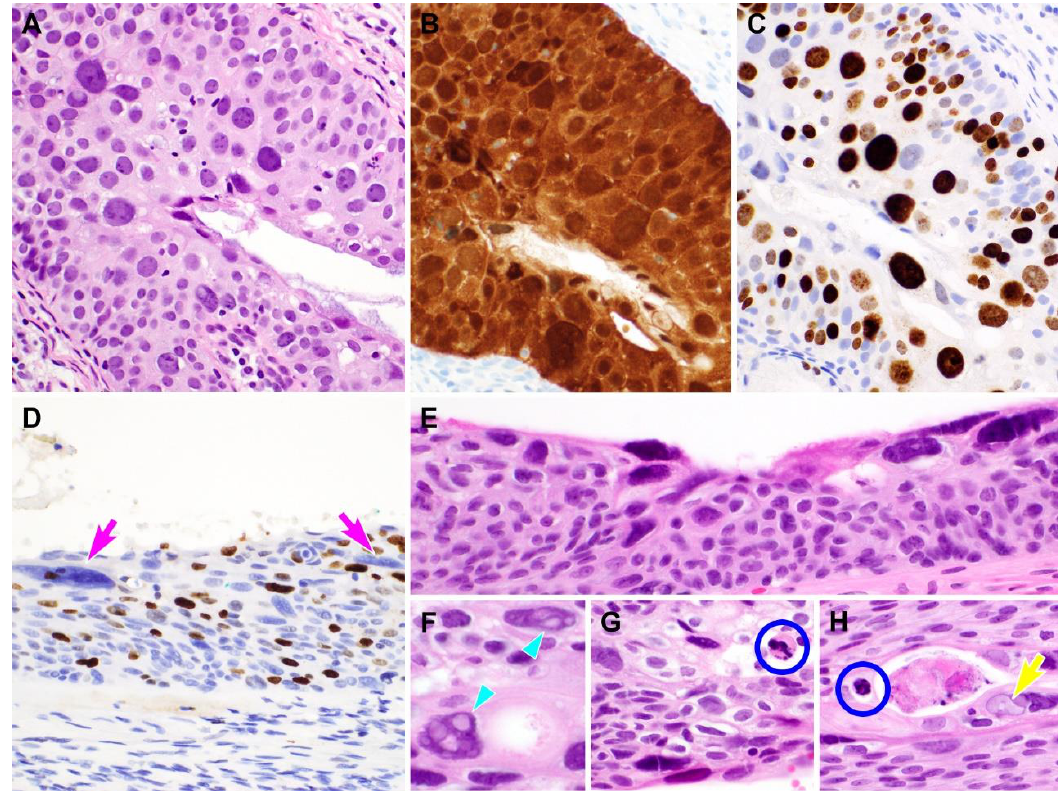
Figure 6. Immunostaining results of pleomorphic high-grade squamous intraepithelial lesion (PHSIL). ( A–C ) PHSIL involving the endocervical glands demonstrates ( B ) block p16 positivity and ( C ) strong Ki-67 expression in most of the pleomorphic cells. ( D–H ) PHSIL cells ( D : two pink arrows) involving the surface epithelium only are not highlighted by Ki-67. ( E – H ) In hematoxylin and eosin-stained slides, ( E ) Ki-67-negative nuclei are mainly located along the luminal surface. ( F ) They show degenerative-appearing chromatin patterns, such as ( F ) intranuclear vacuoles (two light blue arrowheads), ( G,H ) pyknosis (two blue circles), and ( H ) ground glass appearance due to the intranuclear inclusion filling the entire nucleus (a yellow arrow). Hematoxylin and eosin staining: ( A ), ( E ), ( F–H ), polymer method: ( B–D ). Original magnification: ( A–H ) = 200×.